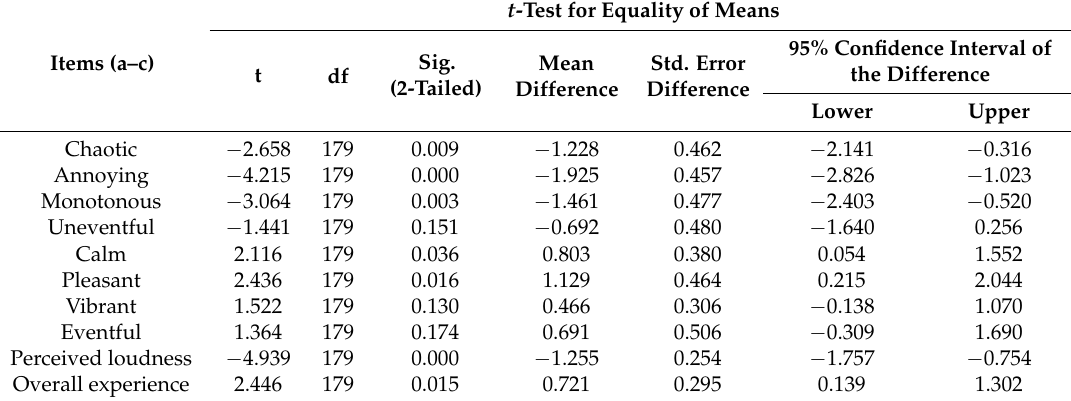
Table 3. Independent-samples t -tests for the Soundscape appraisal, Perceived loudness and Overall experience items between the NSS